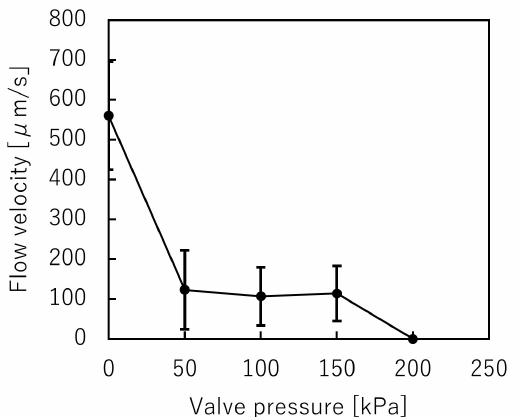
Figure 10. Variations of the mean beads velocity and the pressure applied to the trapezoid-shaped cross-section pneumatic microvalve ( n = 2).